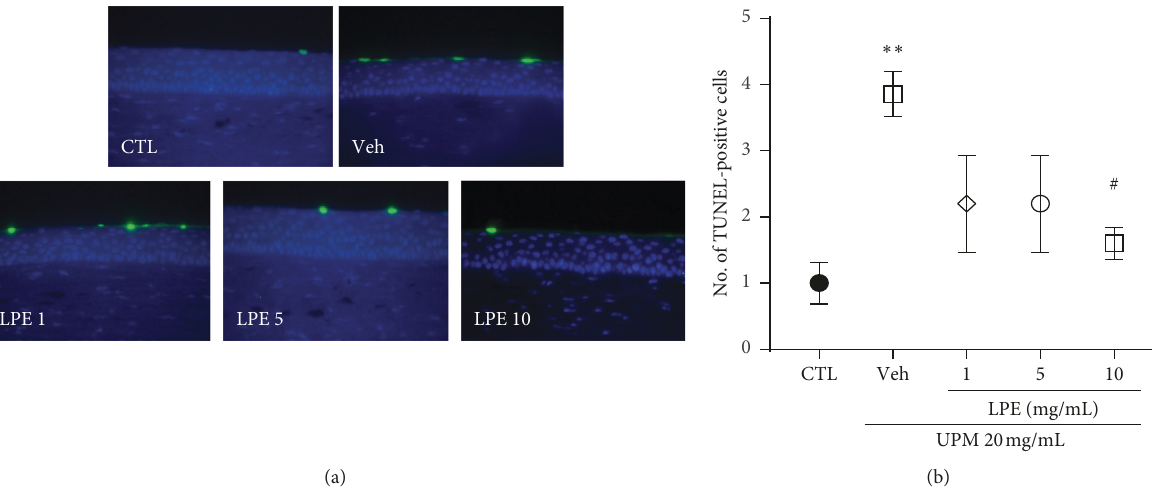
Figure 4: Terminal deoxynucleotidyl transferases dUTP nick-end labeling (TUNEL) assay. (a) Representative images of TUNEL-positive cells within the Control (CTL), Vehicle (Veh), and Liriope platyphylla extract (LPE) (1, 5, and 10mg/mL) groups. (b) Graph of the number of TUNEL-positive cells. Data shown are mean ± standard error. ∗∗ p < 0 . 01 vs. CTL; # p < 0 . 05 vs.